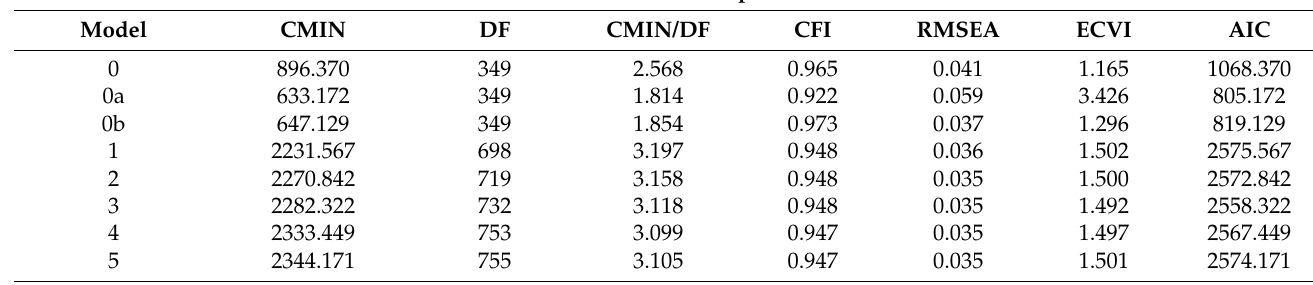
Table 3. Adjustment statistics for the models. Comparison between models using model 1 as correct in the two groups of users aged 12–16. Goodness-of-Fit Indices and Model Comparisons for Tested